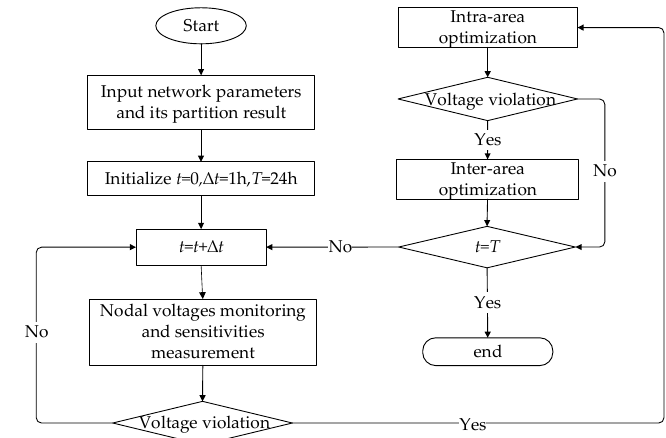
Figure 2. Flowchart of the proposed decentralized control strategy of SOPs.